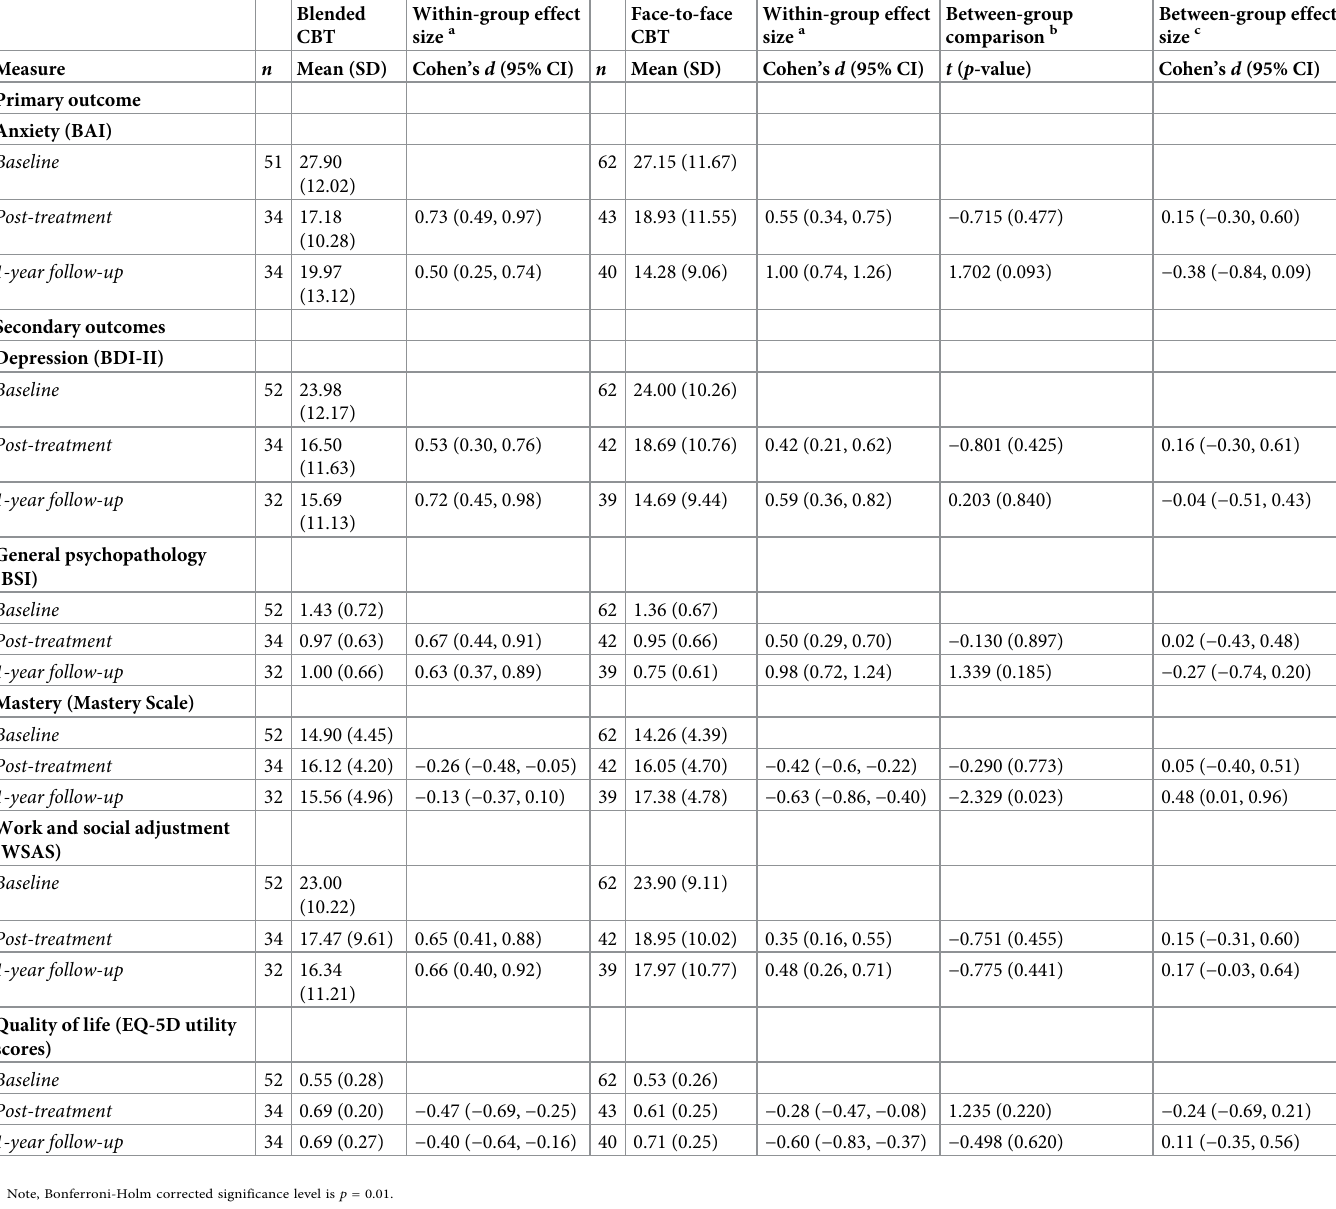
Table 2. Observed means and standard deviations for clinical outcome variables at baseline, post-treatment and one-year follow-up within each group, within- group effects and between-group effects based on estimated means. Blended